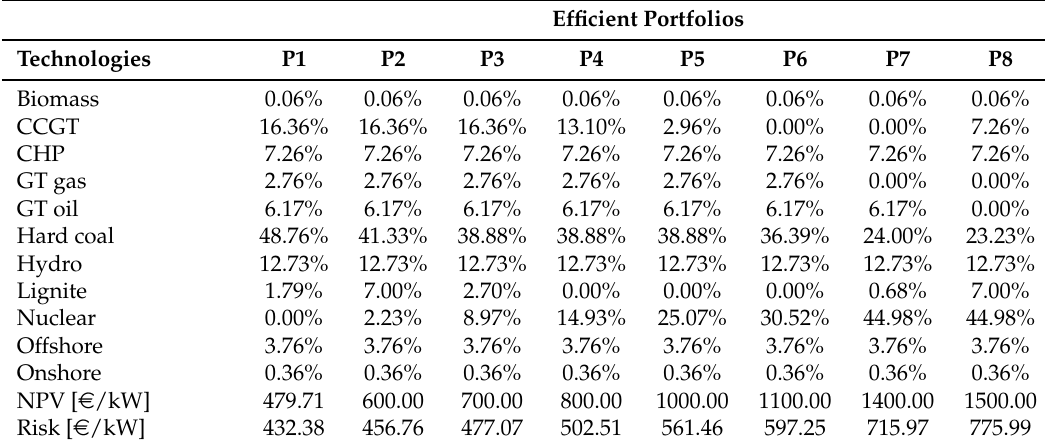
Table A4. Efficient portfolios according to FSMAD Model 2 for existing technologies combined with new investments.